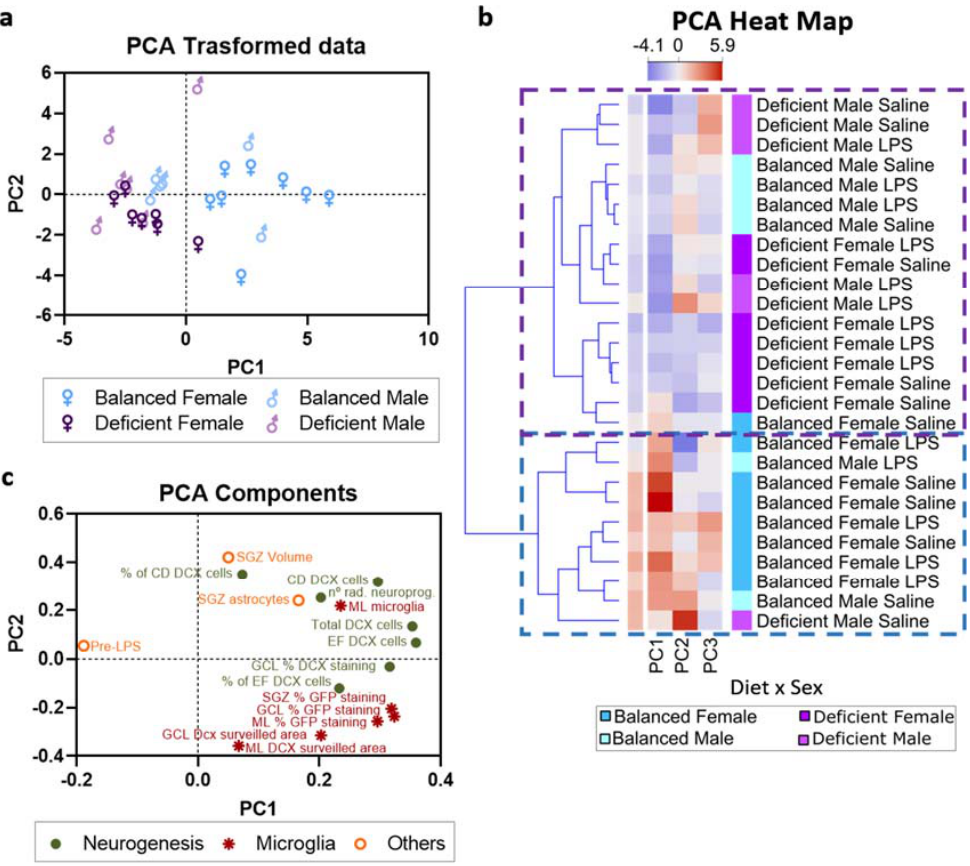
Figure 10. Principal component analysis (PCA) indicated a prominent effect of diet in female mice. ( a ) Principal component 1 (PC1) and principal component 2 (PC2) explained 62% of the variance of the selected data. The PCA-transformed data distribution showed relevant differences between female mice fed with the n-6/n-3 PUFA balanced diet and the other groups. ( b ) PCs 1, 2 and 3 were used to classify mice, and two main clusters were obtained (dotted lines). The heat map divided mice into two clusters (dotted lines). ( c ) PC1 was mainly influenced by adult neurogenesis and microglial ‐ related parameters, while PC2 was mainly influenced by a mixture of features related to adult neurogenesis, microglia, and others (PCA values detailed in Supplementary Data).